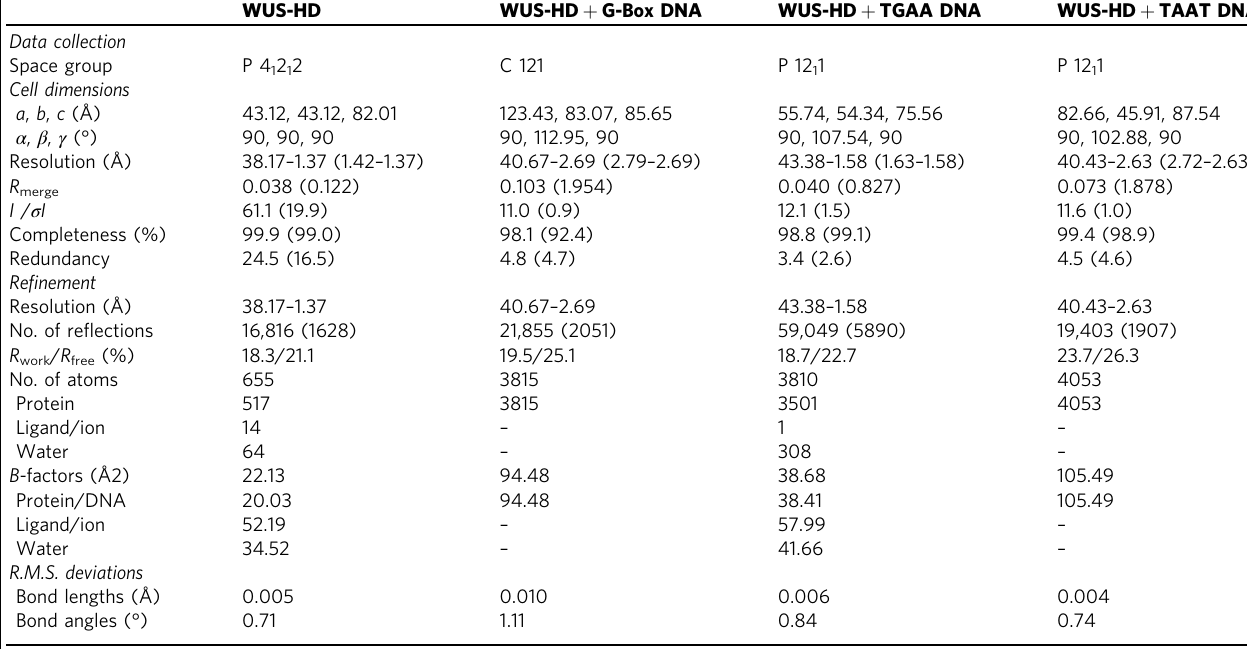
Table 1 Data collection and re fi nement